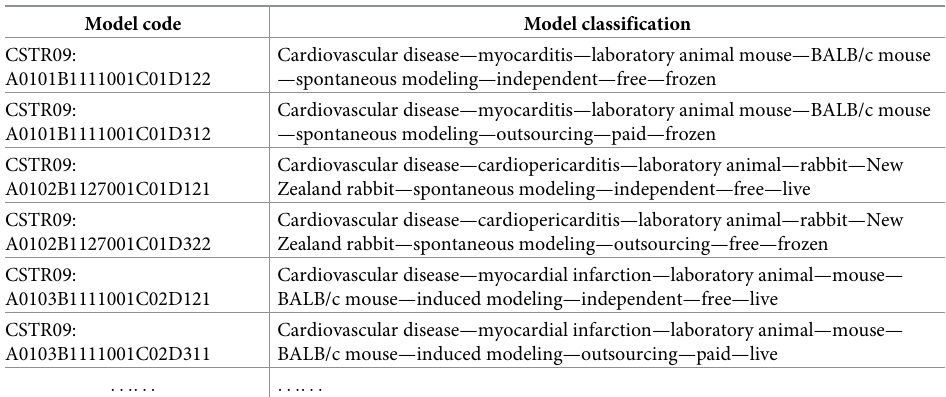
Table 4. Model classification and coding table